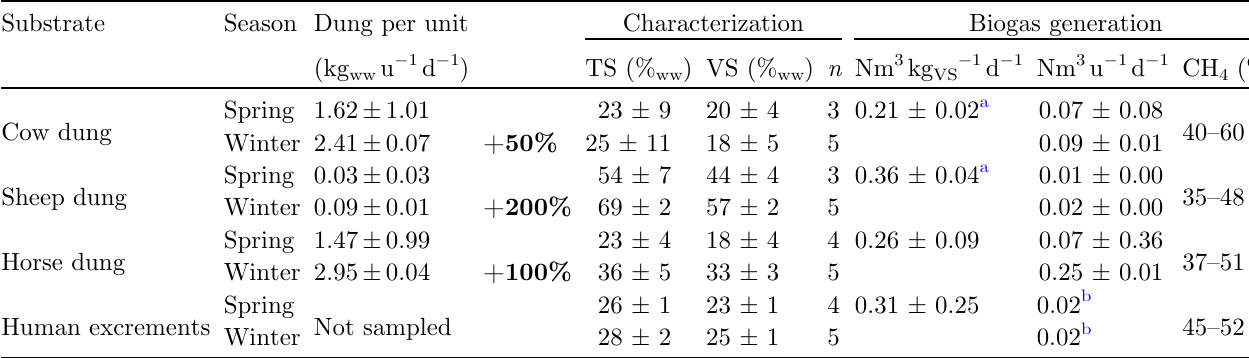
u (cid:1) 1 d (cid:1) 1 ), ww ), ww ranges. 4